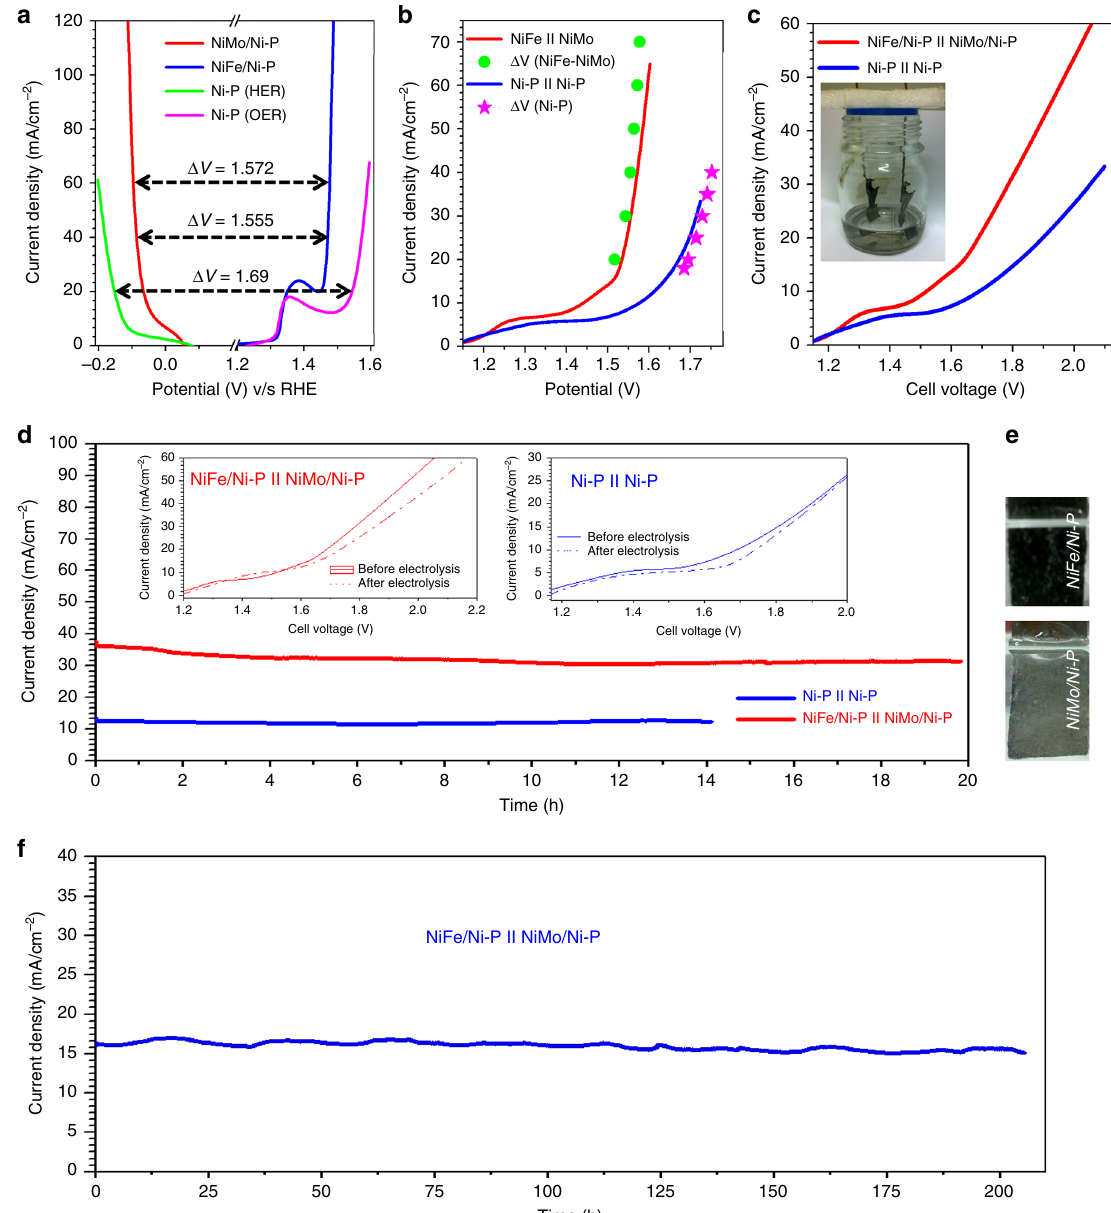
Fig. 9 Electrocatalytic performance of 2-electrode cell and long-term stability under continuous operation. a Steady state polarization curves of Ni-P, NiFe/ Ni-P and NiMo/Ni-P under OER and HER conditions with corresponding voltage differences at fi xed current densities. b Steady state polarization curves of NiFe-NiMo and bi-Ni-P electrolyzers (with iR-correction) in 1 M KOH along with corresponding voltage difference plots. c The analogous polarization curves without iR-correction. Inset showing the assembly of an electrolyzer. d Chronoamperometric stability test of NiFe-NiMo and bi-Ni-P electrolyzers in 1 M KOH at 1.75 V. Inset shows steady state LSVs before and after bulk electrolysis. e Digital images of the electrodes under operating conditions showing release of gas bubbles. f Long term chronoamperometric stability test of NiFe-NiMo electrolyzer in 1 M KOH at 1.7 V in the practical device condition i.e., near 10 mA cm −